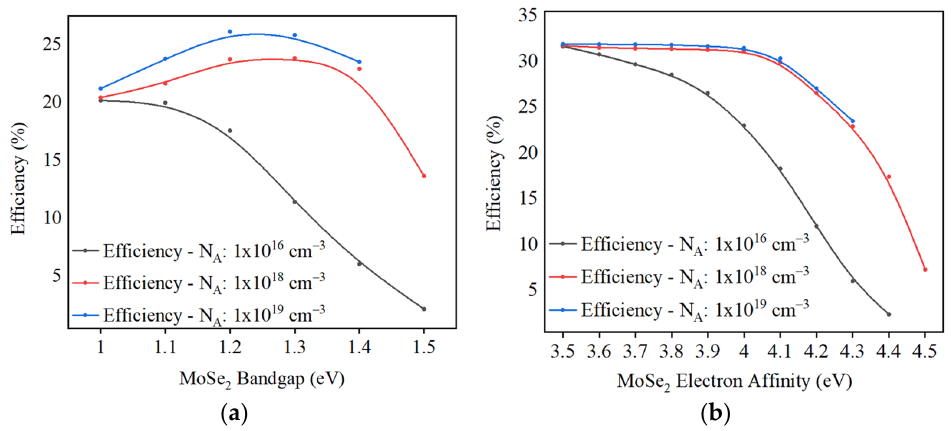
Figure 5. Effects of ( a ) 𝐸 (cid:3034) ; ( b ) 𝜒 on the PCE with carrier concentration of 10 16 , 10 18 , and 10 19 cm − 3